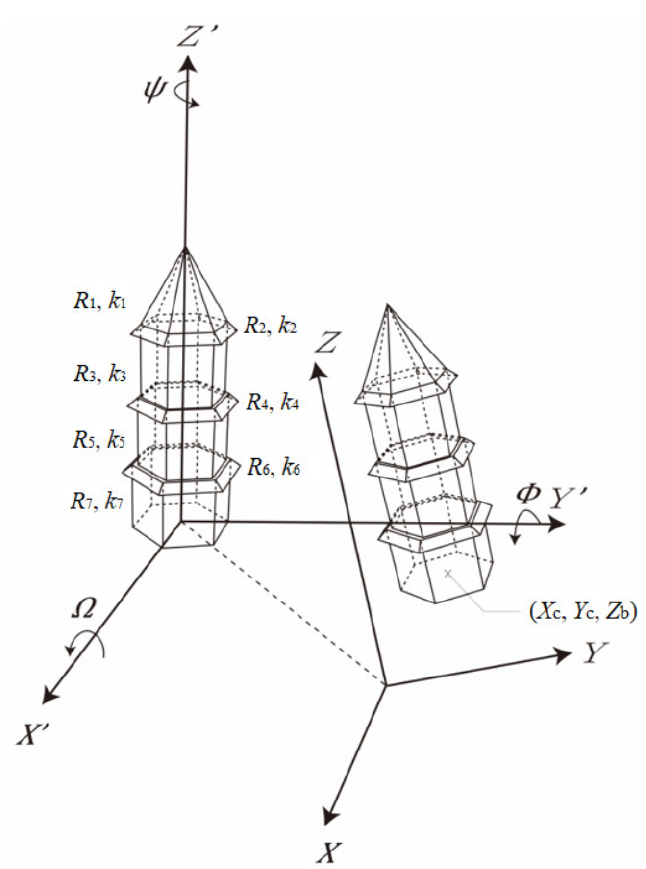
Figure 5. Model parameters of the proposed geometric model for the entire hexagonal